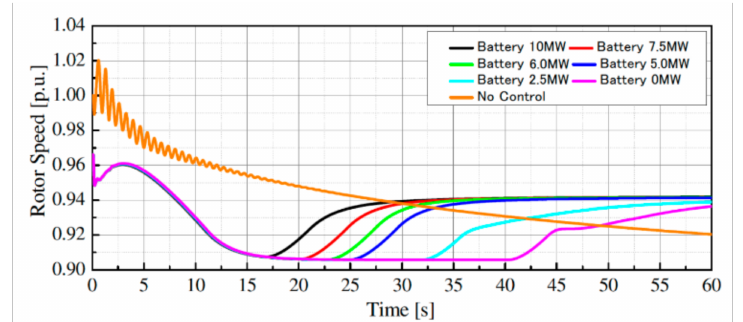
Figure 24. Generator rotor speed (II) (Pumping